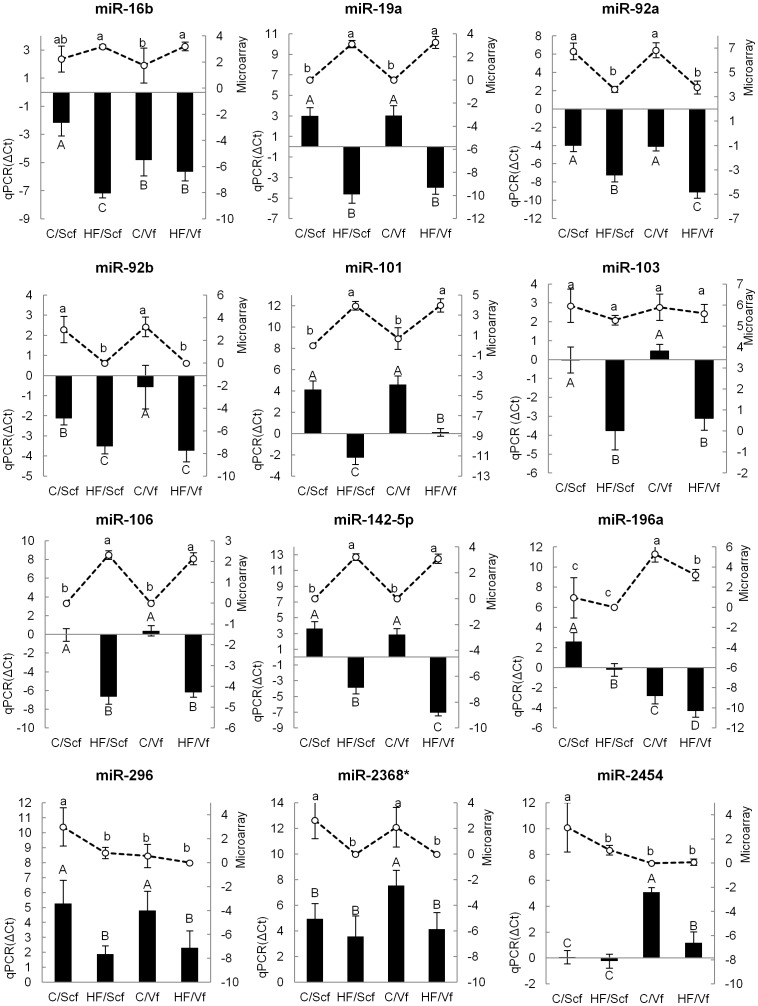
Expression of miRNAs by qRT-PCR and microarray.MicroRNA expression is presented for the following treatments on the horizontal axis: Control diet/Subcutaneous fat (C/Scf), High fat diet/Subcutaneous fat (HF/Scf), Control diet/Visceral fat (C/Vf) and High fat diet/Visceral fat (HF/Vf). The graphs show the miRNA expression from miRNA microarray represented by lines (–○–) on the top and values are shown on the left vertical axis as normalized intensity values. Quantitative PCR expression is represented using columns (←) on the bottom and values are shown on the right vertical axis as delta cycle threshold (ΔCt). A, B, C, D Columns (qPCR) with different letters differ significantly (p<0.05). a, b, c Markers in lines (microarray) with different letters differ significantly (p<0.05). Data are presented as Mean ± Standard deviation.